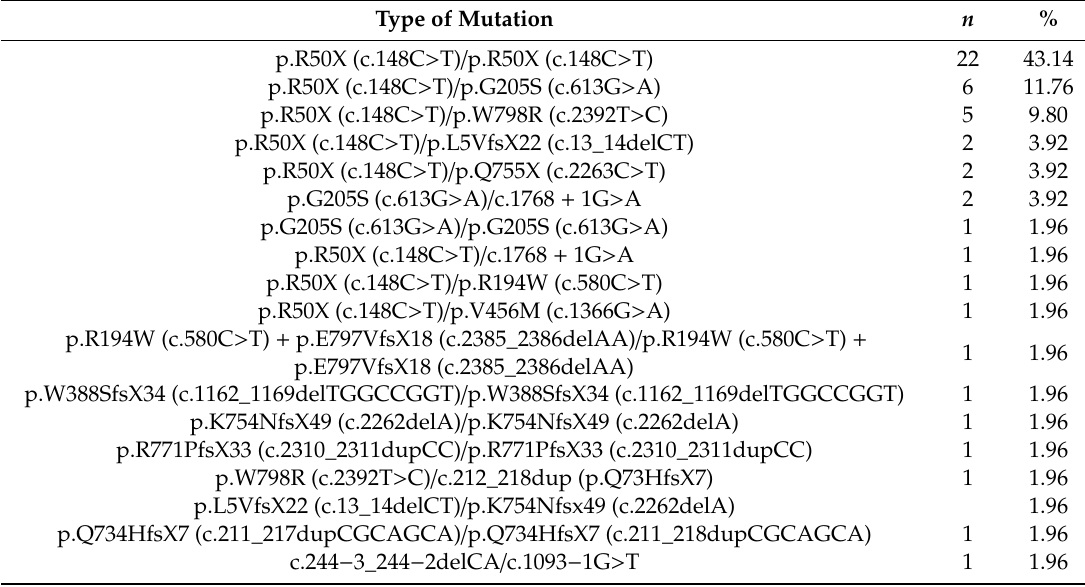
Table 1. PYGM mutations identified in the study patients ( n = 51).